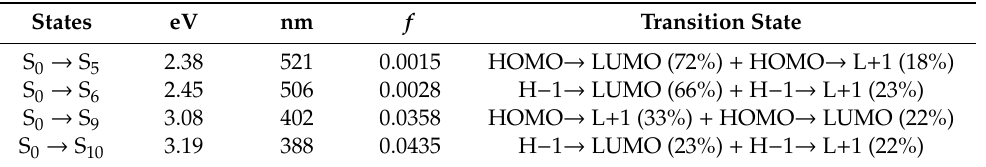
Table 5. The lowest excitation energies in eV and oscillator strength ( f ) in the solvent phase (in ethanol) using the TD-PBE0 / 6-311G(d,p) method for the Ni-TEA complex. The highest occupied molecular orbital (HOMO) is donated by H and L is the lowest unoccupied molecular orbital (LUMO).